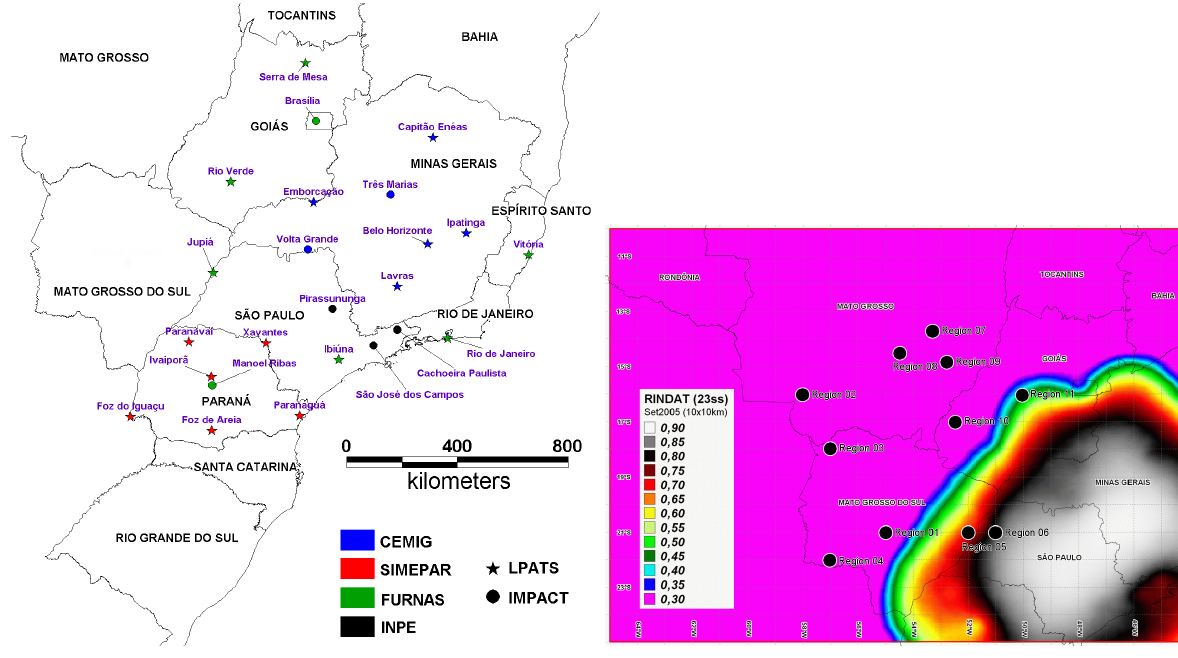
Fig. 9. Location of BrasilDAT sensors on the left, and modeled detection efficiency showing approximated locations of the convective region centers at 23:53UT, on the right (adapted from Naccarato,